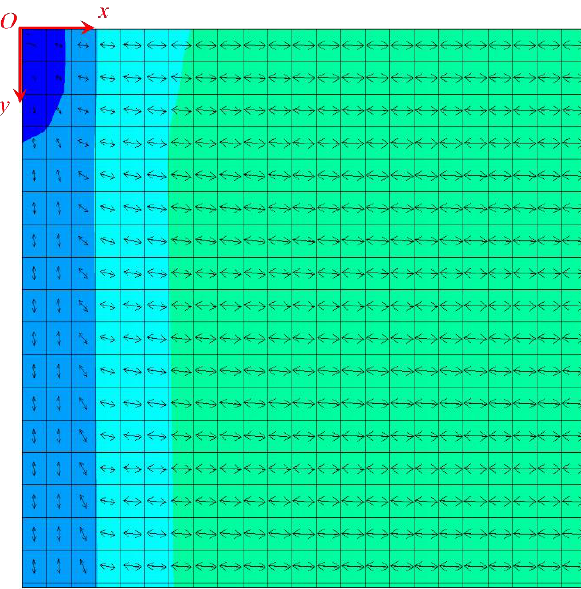
Figure 6. First principal stress direction of the film when the loading ratio was y : x = 2.